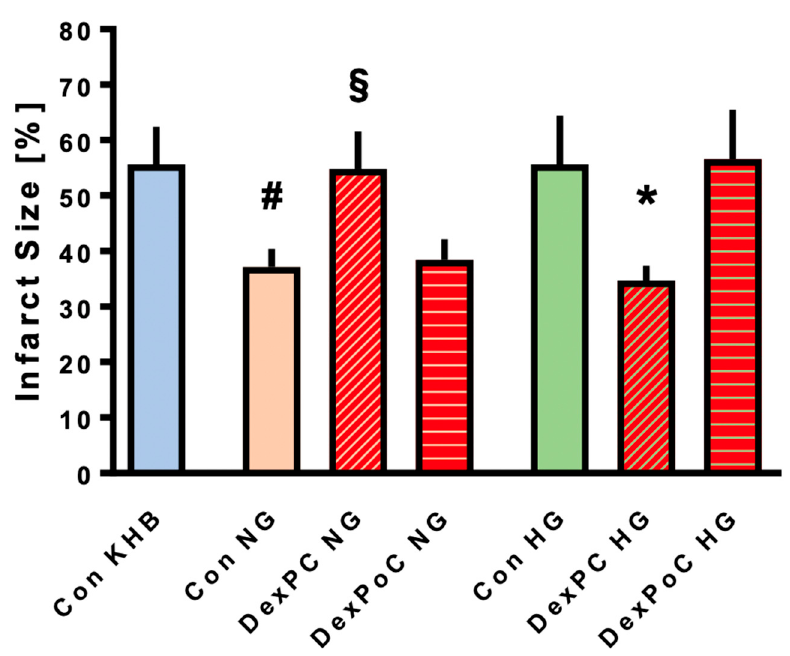
Figure 2. Infarct size measurements. Figure shows the infarct size of controls (Con) and Dexmedetomidine (Dex) treated groups under hyperglycemia (HG) or normoglycemia (NG). PC = Preconditioning, PoC = Postconditioning. Data are presented as means ± SD, * p < 0.05 vs. Con HG and DexPoC HG, respectively, # p < 0.05 vs. Con KHB, § p < 0.05 vs. Con NG and DexPoC NG, respectively. NG,